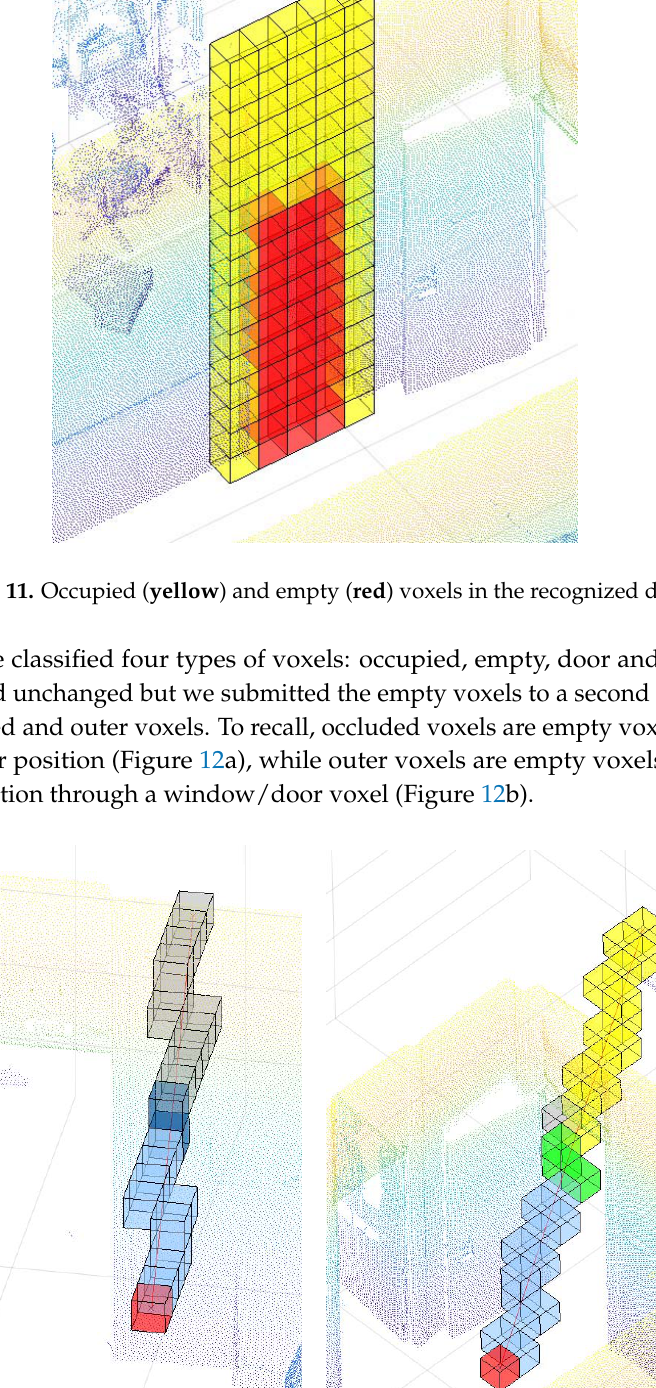
Figure 13. Discretized room. Voxel plane 1.5 m high. Dark blue: occupied; light blue: empty; green: door; magenta: window; grey: occluded; yellow: out; black: scanner position. 2.3. Next Best View The main objective of this method was to calculate the optimum scanning position to automatically perform complete scanning of the site with the minimum number of scans, starting from an arbitrary position in the room and without any other previous information. This optimal scanning position was defined as next best view (NBV). This is the position where the robot should stop to perform the scan using a stop-and-go survey procedure. To calculate the NBV, the previously created voxel space was used (Figure 13). The method consisted of checking the feasibility of every voxel as an NBV candidate in terms of safety and significance. The safety condition takes into account the size of the scanner station ( (cid:1860) (cid:3046)(cid:3030)(cid:3028)(cid:3041)(cid:3041)(cid:3032)(cid:3045) = 1.5 m). It is defined as a cylinder-centred buffer on the candidate voxel with height (cid:1860) (cid:3046)(cid:3030)(cid:3028)(cid:3041)(cid:3041)(cid:3032)(cid:3045) (cid:3397) 0.5 m and a